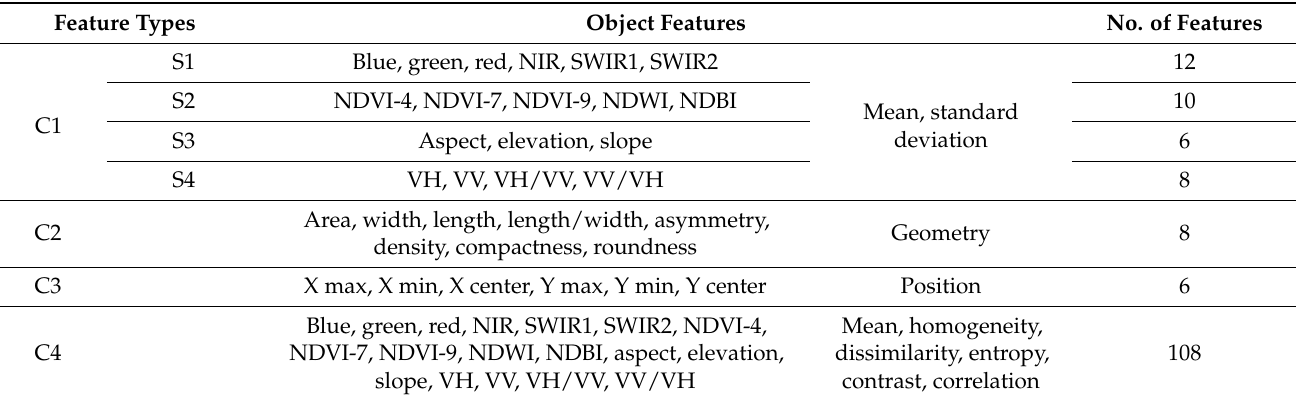
Table 3. Object features used in object-based